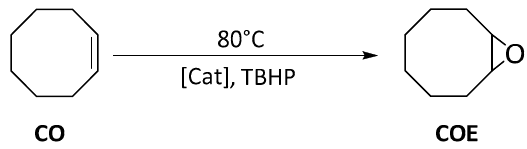
Table 2. Calculated ρ (NH 2 ) and ρ (PM) data and surface coverage μ (NH 2